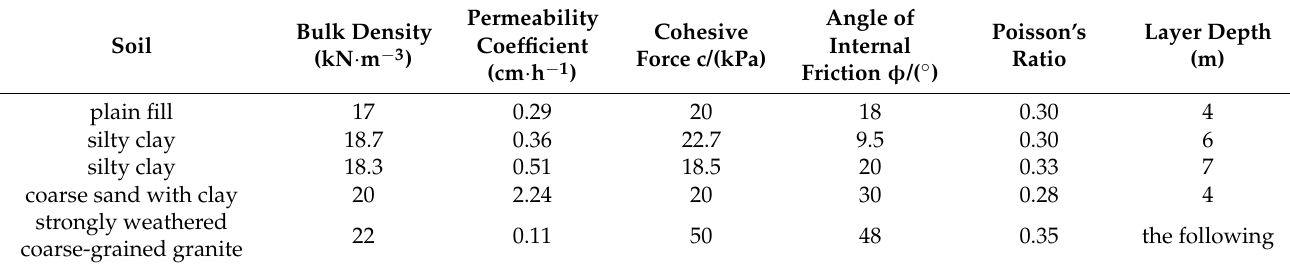
Table 3. Geotechnical layer parameters.